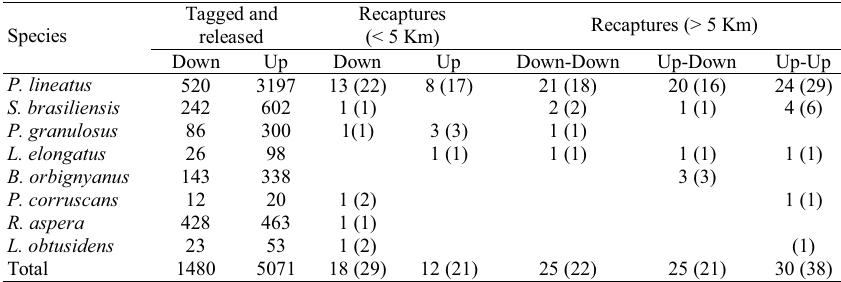
Table 2. Number of tagged, released and recaptured individuals downstream (Down) and upstream (Up) from the Porto Primavera Reservoir. In the recaptures, the number of individuals captured within the first 71 days after their release (outside parentheses) are differentiated from those individuals with periods less than 300 days and speeds above 1 km/day (between parentheses). The combinations Down-Down, Up-Down, and Up-Up indicate the release and recapture localities